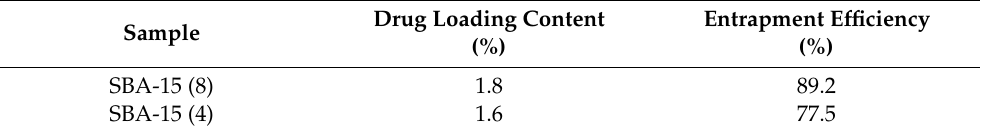
Table 3. Drug loading and entrapment efficiency of rhBMP-2 protein into SBA-15 MSNs. Table 3. D rug loading and entrapment efficiency of rhBMP ‐ 2 protein into SBA ‐ 15 MSNs.